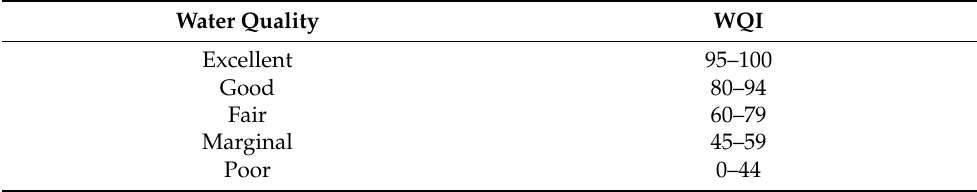
Table 2. Water Quality Index characterization.